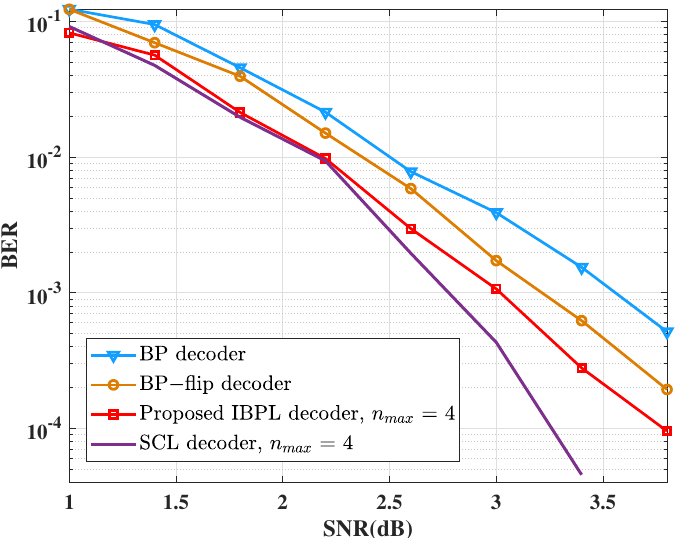
Figure 7. BER performance comparison among IBPL decoder, BP decoder, BP-flip decoder, and SCL decoder when code length is 128 bits, code rate is 1/2, and n max =